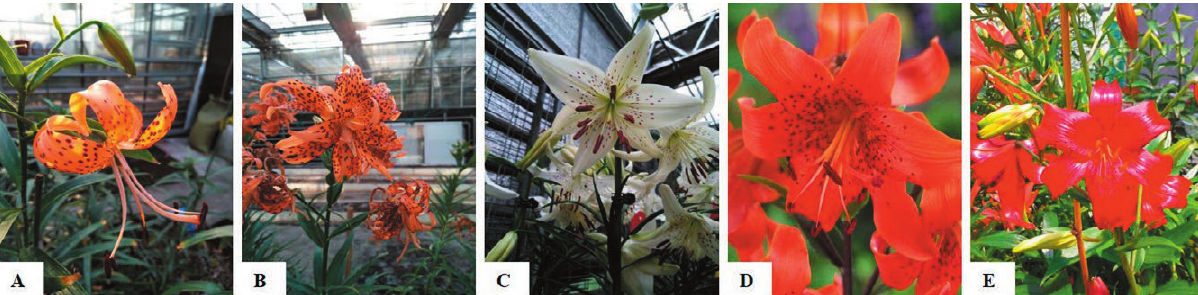
Figure 1. The five materials in this study. A: L. lancifolium , B-E: L. lancifolium cultivars: 'Flore Pleno', 'Sweet Surrender', 'Red Life', 'Red Vel- vet',